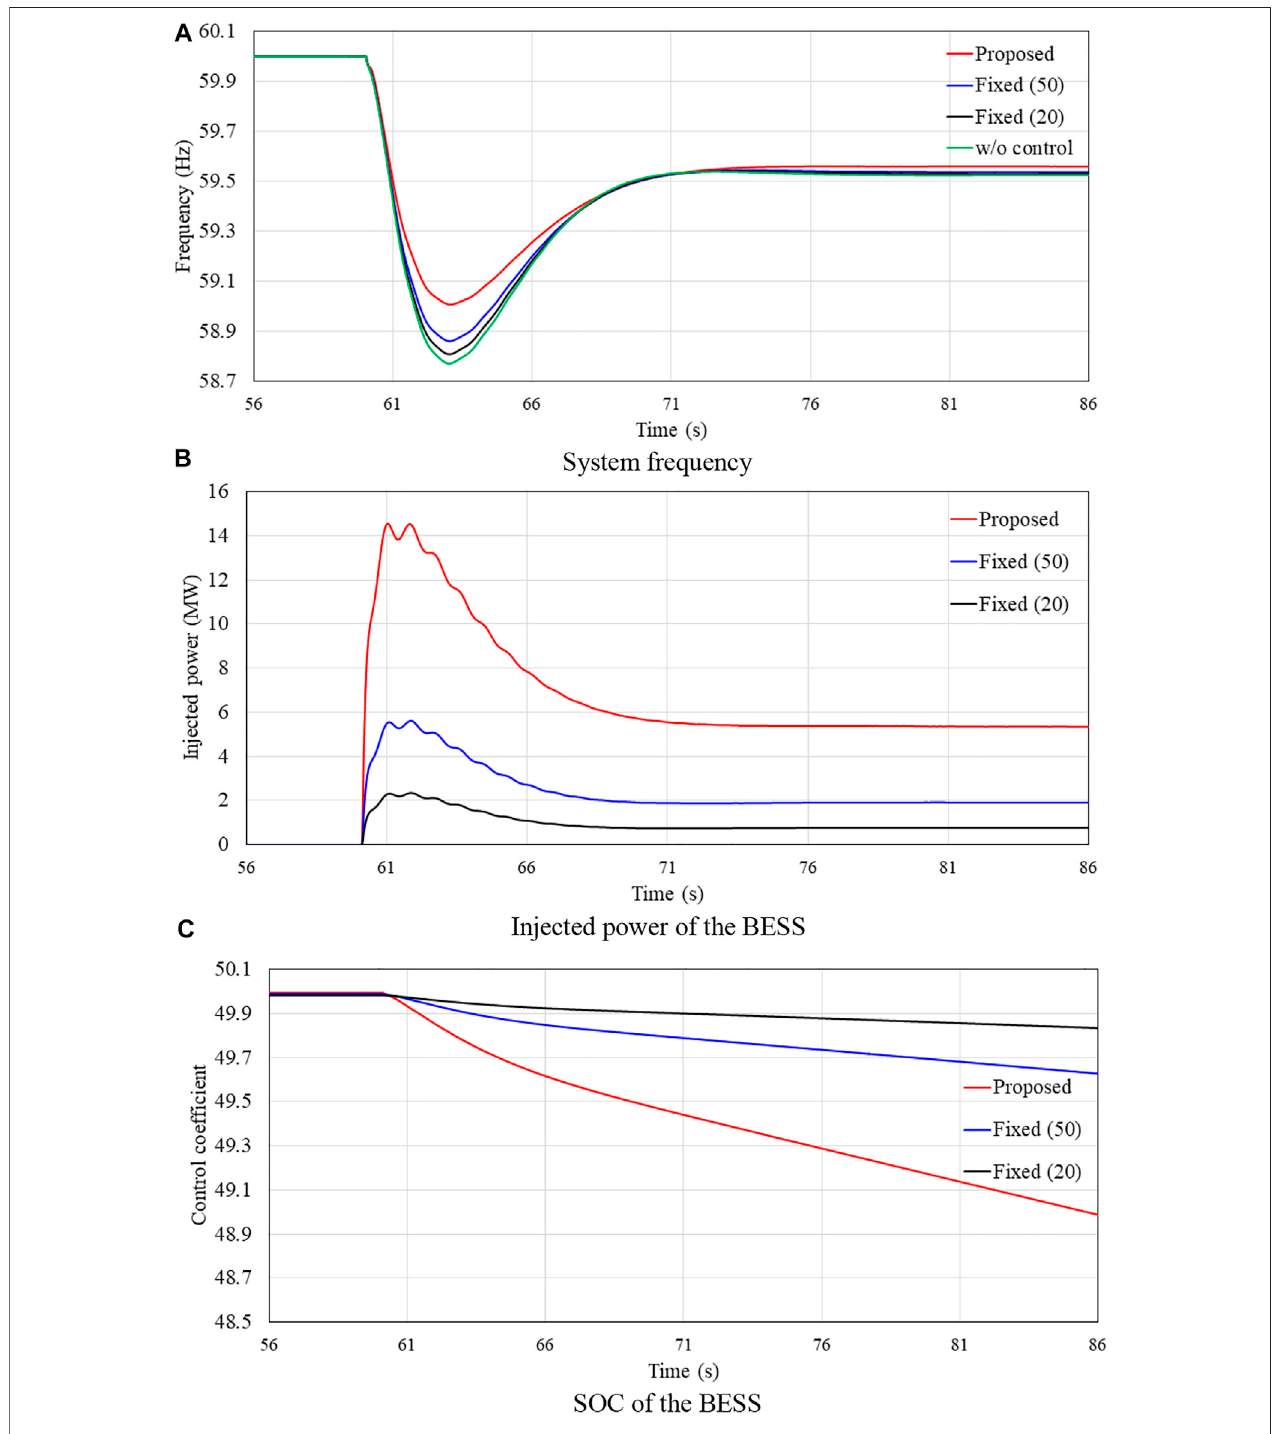
FIGURE 7 | Results for case 2. (A) System frequency. (B) Injected power of the BESS. (C) SOC of the BESS.